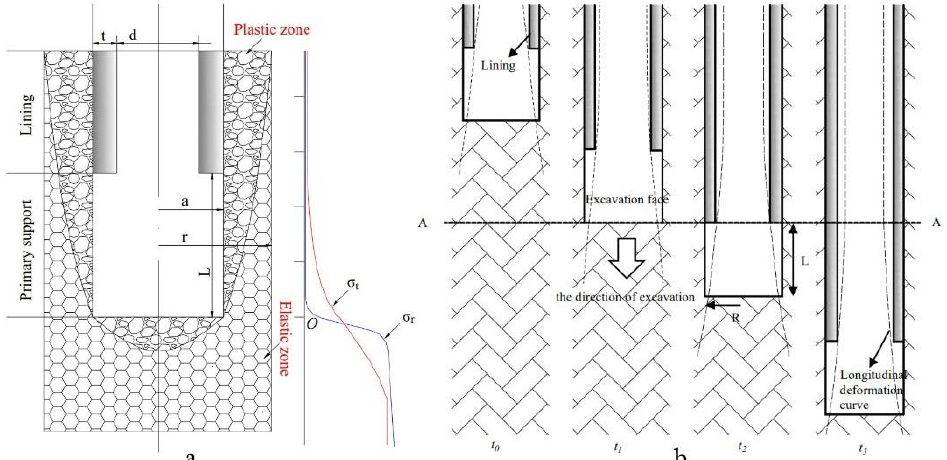
Figure 3. Stress of the longitudinal section from ASGR. (( a ) is the longitudinal section stress curve of ASGR; ( b ) is the schematic diagram of ASGR releasing stress by increasing the distance between the lining and driving face).